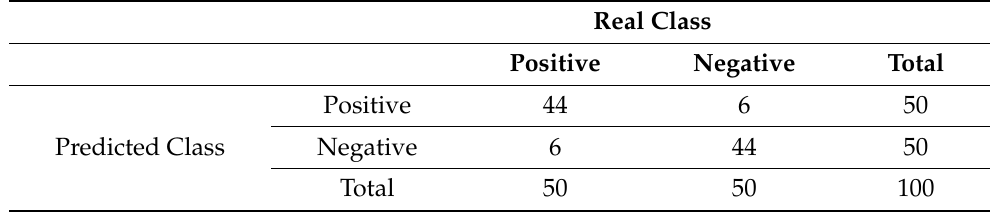
Table 6. Confusion matrix of the results obtained by the SVM-based classifier using a set with 20 features along with the test set containing 100 instances from Antczak’s